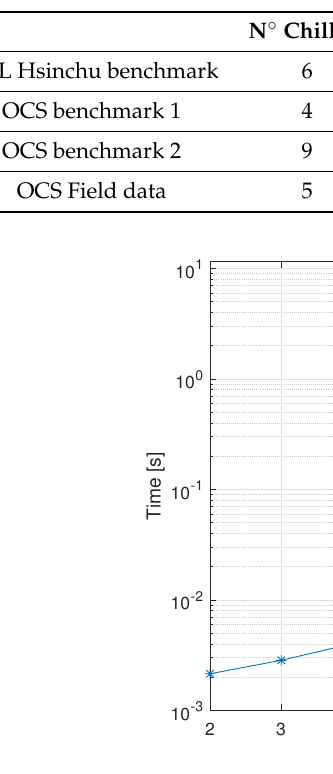
Figure 11. Simulated X-OCL experiment: average computation time per